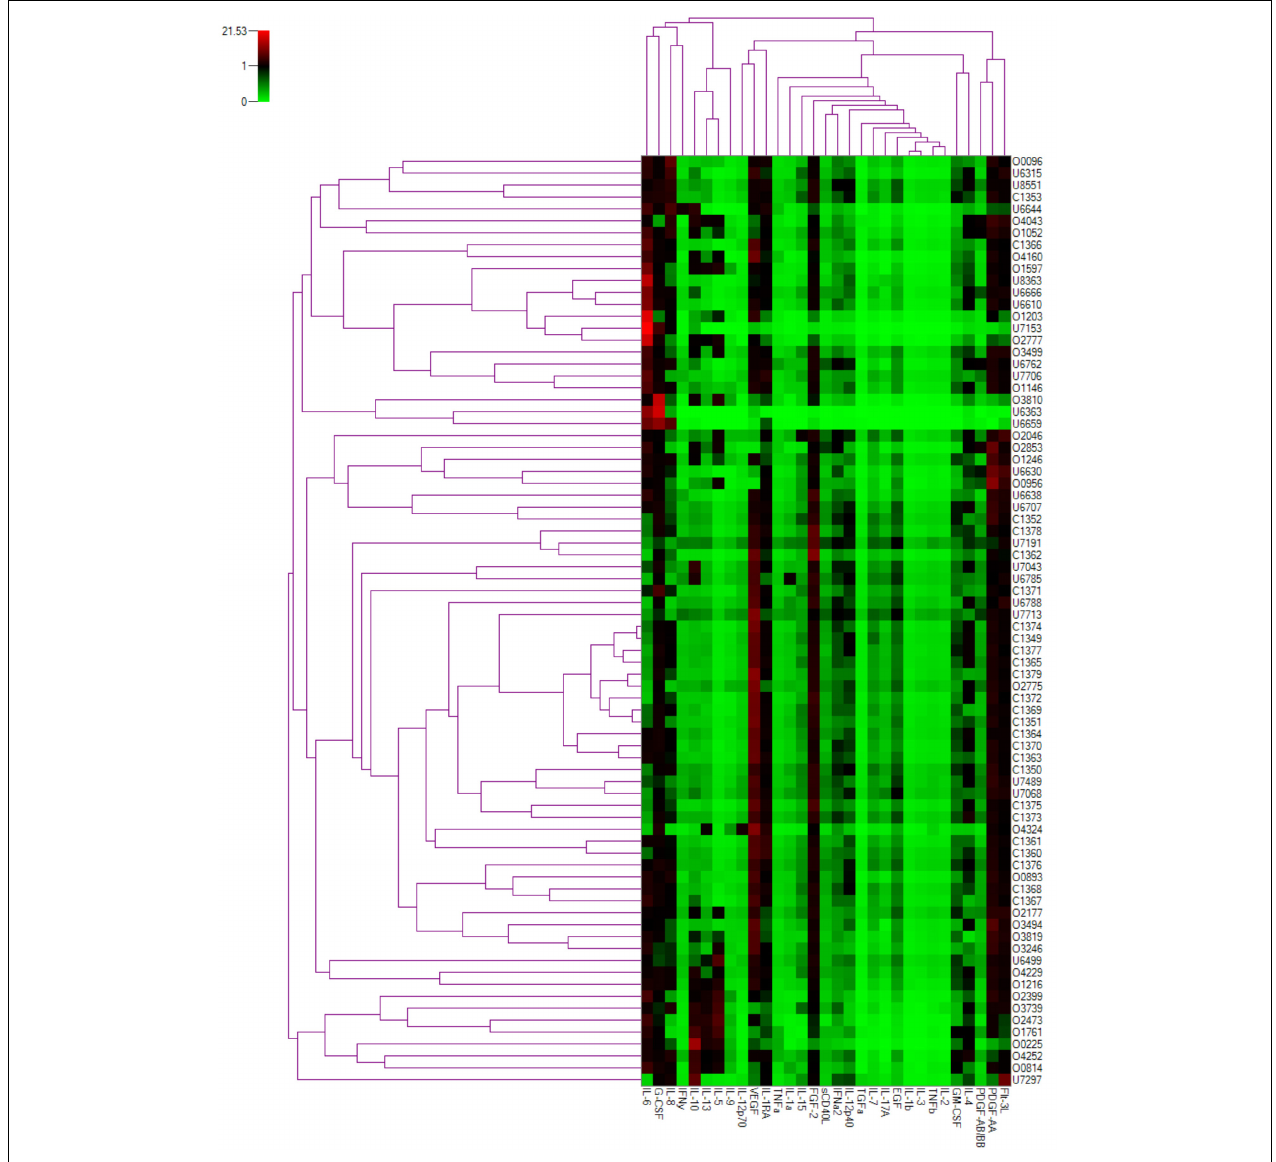
FIGURE 4 | Two-dimensional cluster analysis of the cytokine dataset. Expression levels of individual cytokines are represented by shades of green to red in the central heatmap, with highest values in bright red and the lowest in light green. The similarity between the profiles of different patients is represented by the left dendrogram, whereas the relationship between cytokines is represented in the dendrogram on the